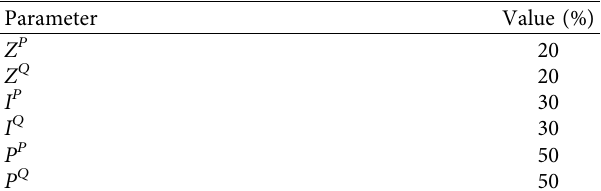
Figure 1: Single-line diagram of standard IEEE 13-bus radial distribution network [58]. Table 1: Data of the ZIP load model